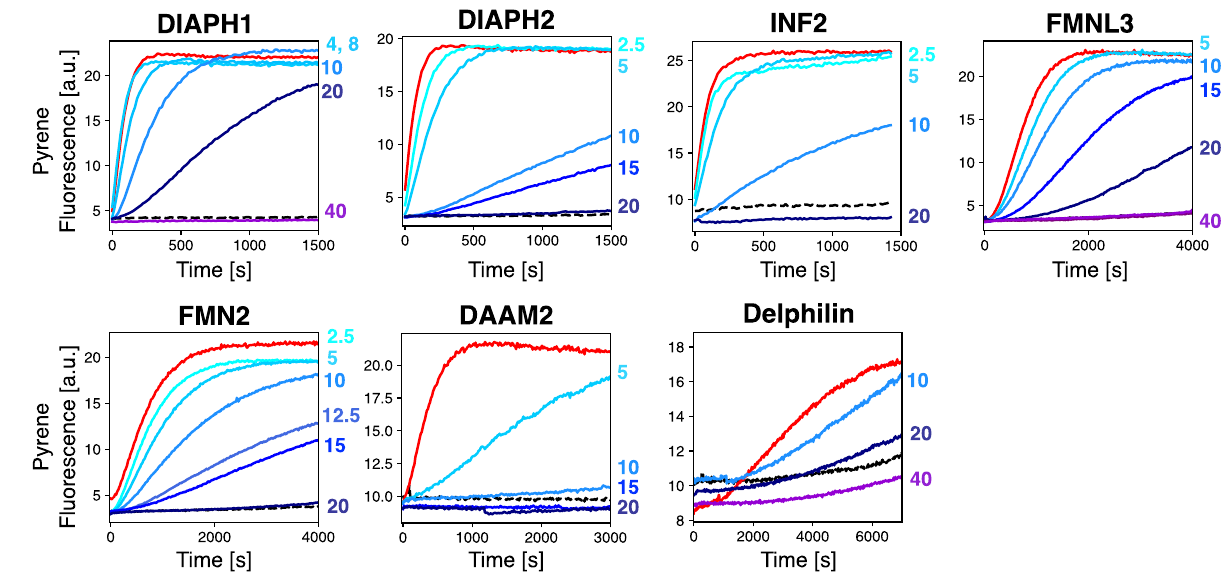
Figure 3. SMIFH2 has broad activity across the human formins. For each titration, pyrene fluorescence was monitored for 2 μM actin (5% pyrene-labeled)/ 4 μM S. pombe profilin. The black dashed line shows profilin/ actin alone, and the red trace corresponds to addition of formin FFC to profilin/actin (5 nM DIAPH1, DIAPH2, INF2; 20 nM FMNL3; 20 nM FMN2; 25 nM DAAM2; 25 nM Delphilin). Increasing concentration of SMIFH2 is indicated by blue traces, with the µM concentration labeled to the right of each plot. The volume of DMSO added was the same for all traces, regardless of SMIFH2